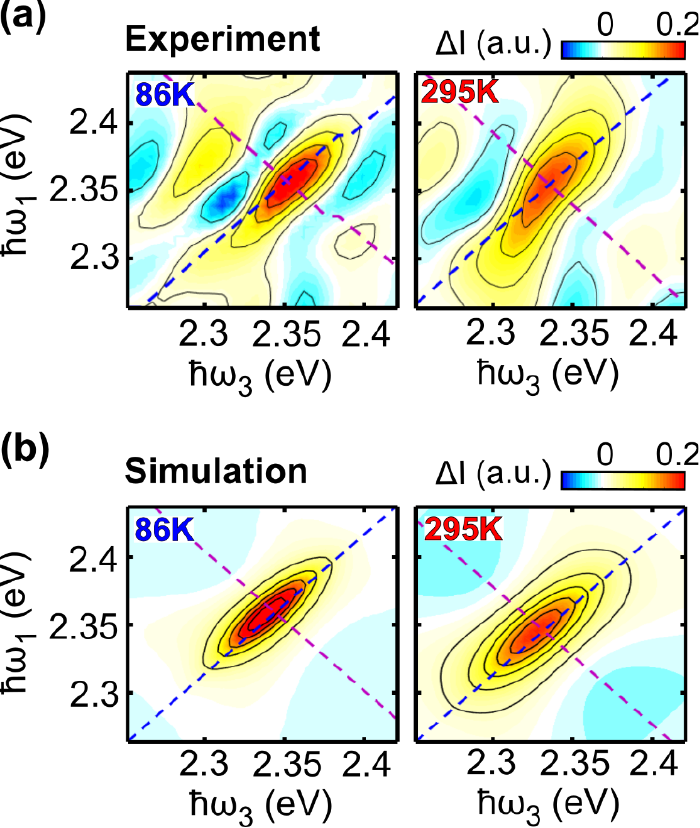
Figure 5. Experimental ( a ) and simulated ( b ) purely absorptive 2DES maps of LFO at 86 K (t 2 = 5 fs) and 295 K (t 2 = 10 fs).